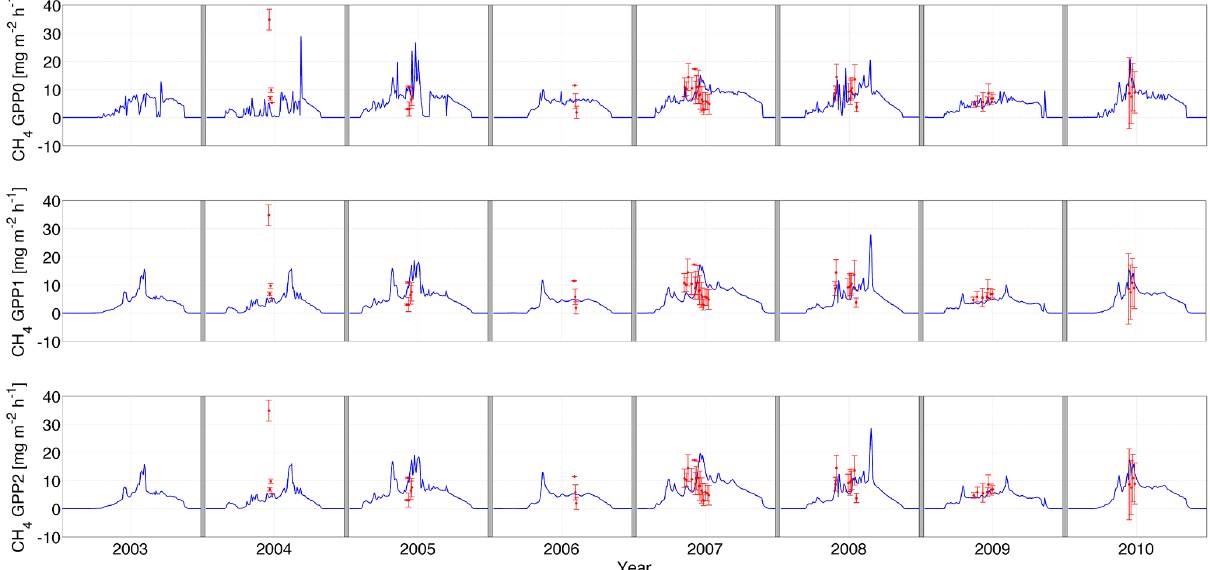
Figure 6. CH 4 flux produced by Peatland-VU compared with data, tundra wet (TW1) group, 2003 to 2010. For data (red), the standard error is shown by an error